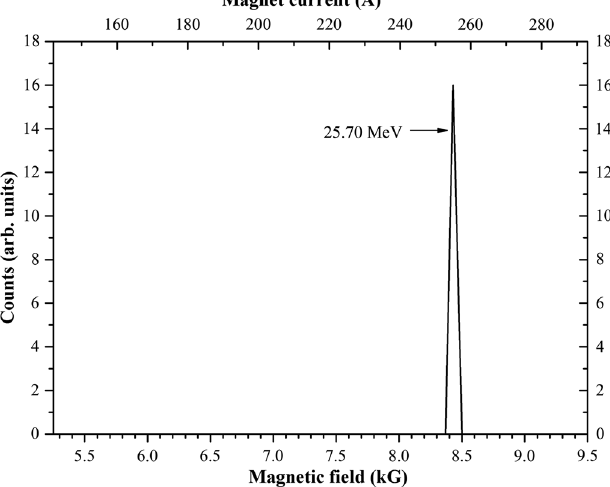
FIG. 16. Spectrum of energy distribution by ions moving through a bending magnet.